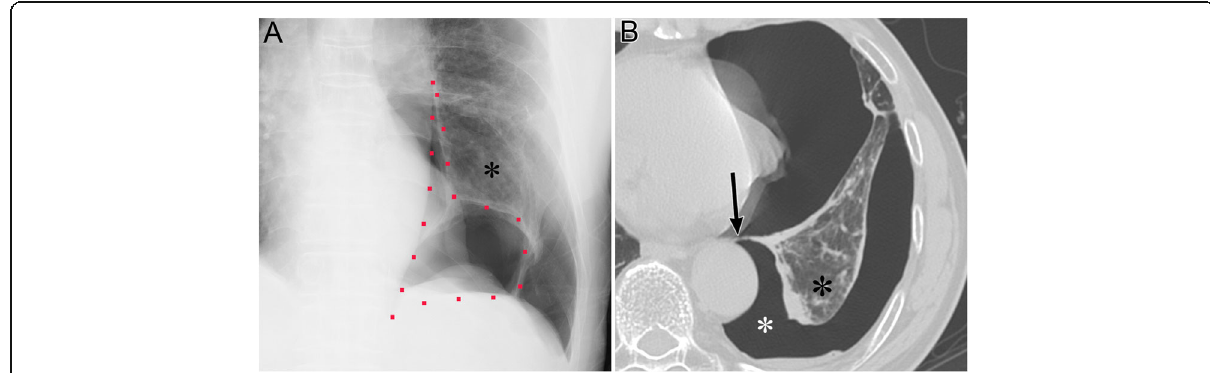
Fig. 6 Pneumothorax in the posteromedial space of an 82-year-old man with chronic obstructive pulmonary disease. a A supine radiograph shows a lucent triangle (red dotted line) with a partially collapsed left lower lobe (black asterisk). The lucent triangle corresponds to the air collection space with its vertex in the hilum and a V-shaped base that delineates the costovertebral sulcus between the paraspinal line/ descending aorta and the medial surface of the partially collapsed lower lobe. b An axial CT image of the lung bases shows pneumothorax in the posteromedial space (white asterisk). The left inferior pulmonary ligament (arrow), which is the linear structure between the mediastinum and the left lower lobe (black asterisk), are clearly visible